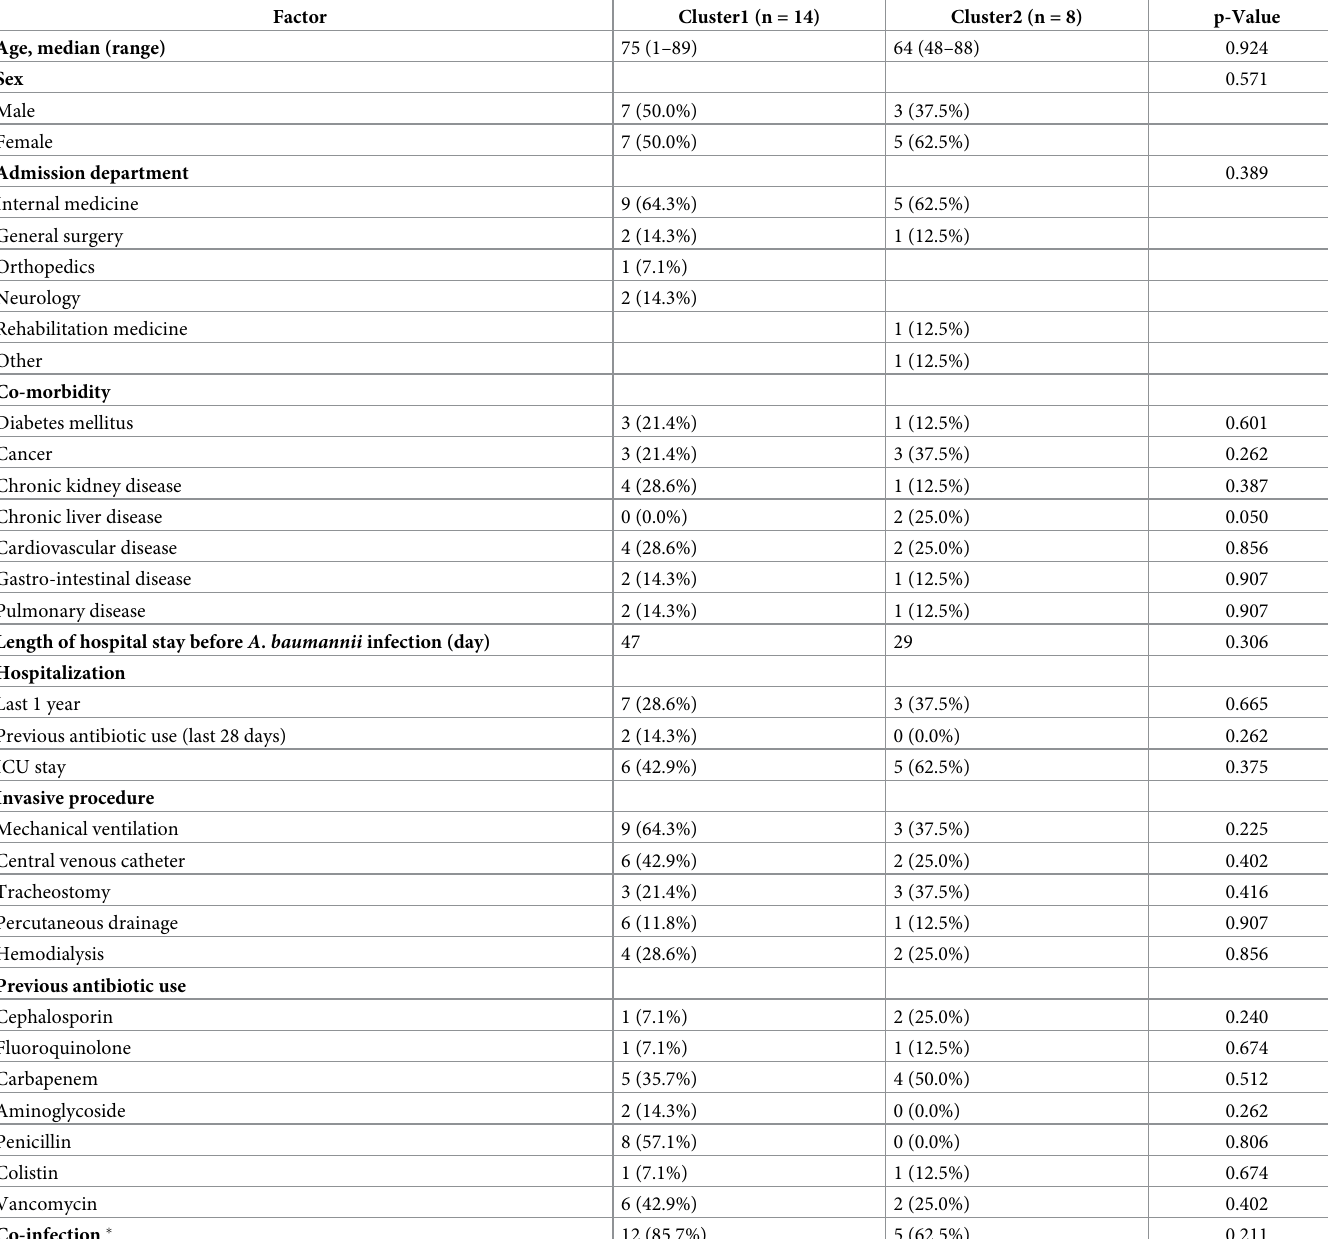
Table 4. Epidemiologic characteristics of Cluster 1 and cluster 2 according to whole-genome multilocus sequence typing (wgMLST).